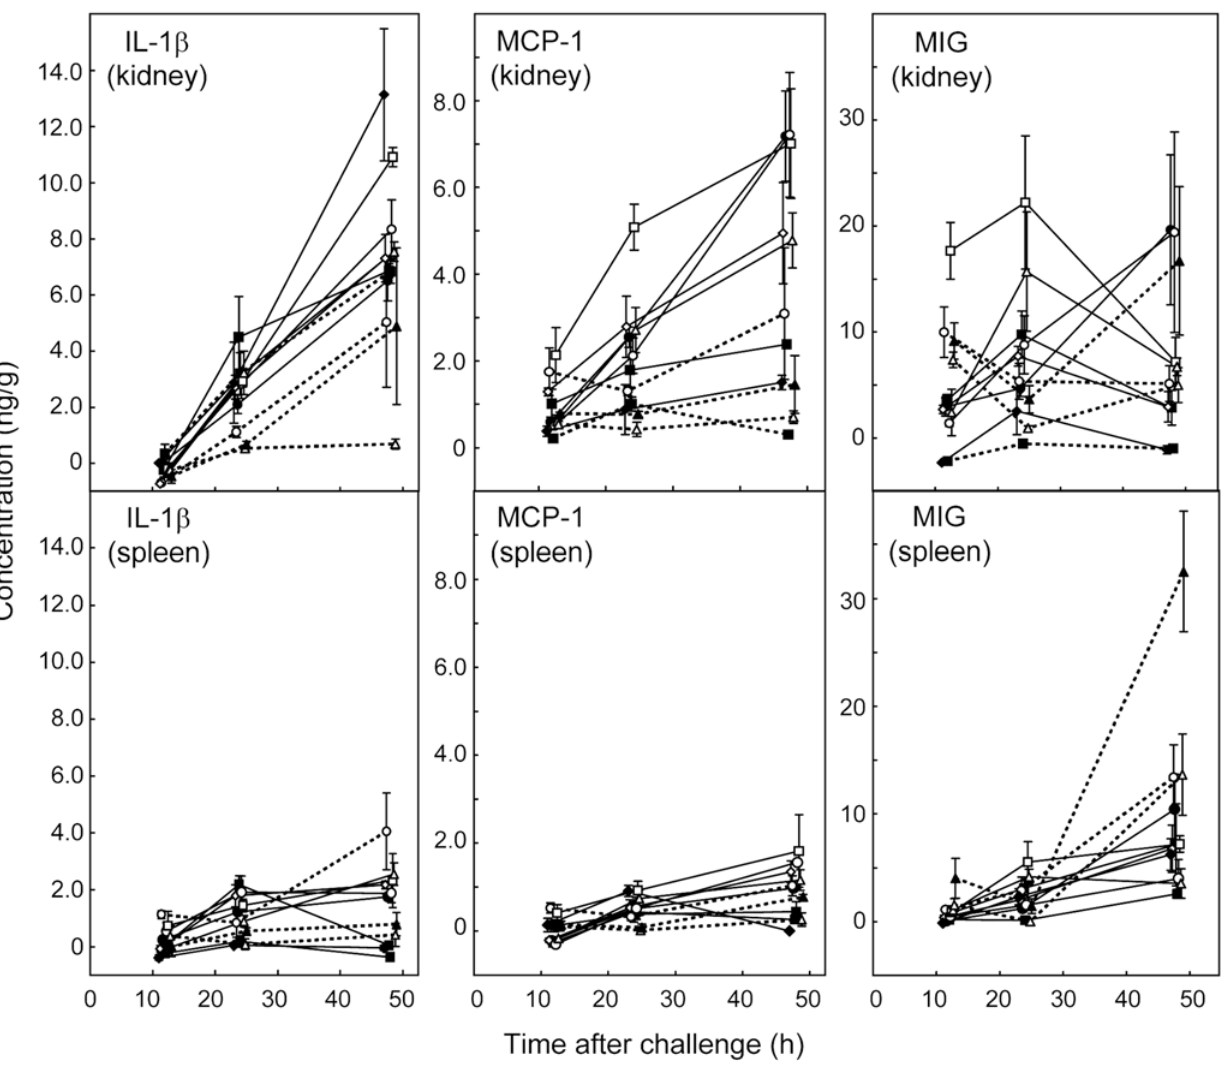
Figure 4. Time course of concentrations (ng/g) of the three most strongly concentrated cytokines or chemokines in supernatants from kidney homogenates after infection of mice with 11 C. albicans strains, together with corresponding data for spleen homogenates. The mean 6 SEM of 3 observations are shown for each time point measured (12 h, 24 h and 48 h). X-axis jitter has been used to aid visualization of the data points. For each immune effector, the scale for the kidney and spleen data is the same, to allow comparison of levels between the two tissues assayed. In each graph, the 11 strains are distinguished as follows: J990102, open circles, solid lines; J951361, filled squares, solid lines; AM2003-020, open triangles, solid lines; IHEM16614, open diamonds, solid lines; SC5314, filled circles, solid lines; s20175.016, open squares, solid lines; AM2003/0074, filled diamonds, solid lines; AM2003/0069, open circles, dotted lines; HUN96, filled squares, dotted lines; Capmr1 , open triangles, dotted lines; Capmr1 + PMR1 , solid triangles, dotted